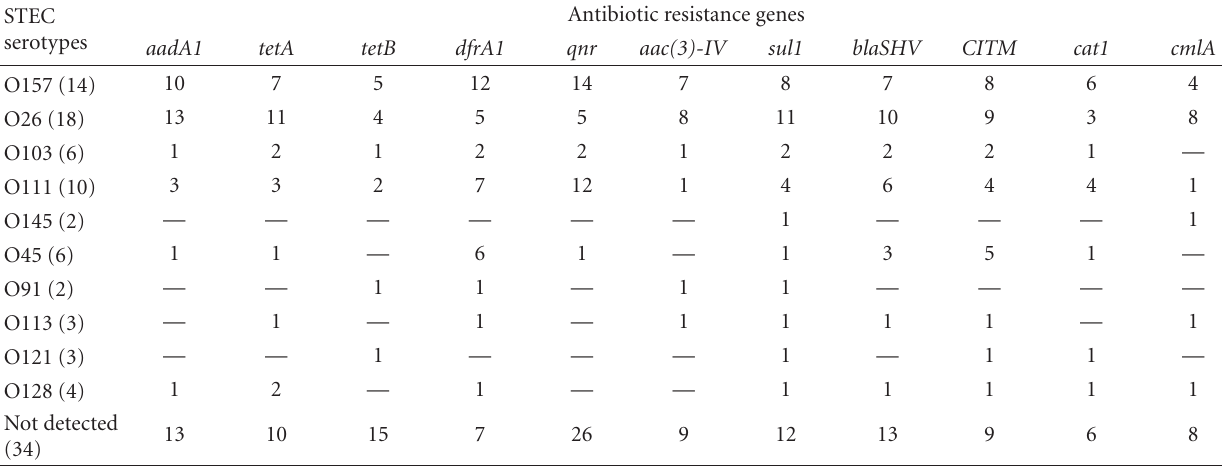
Table 6: Distribution of antibiotic resistance genes in various serotypes of E. coli isolated from raw animal milk samples and traditional dairy products in Iran. STEC